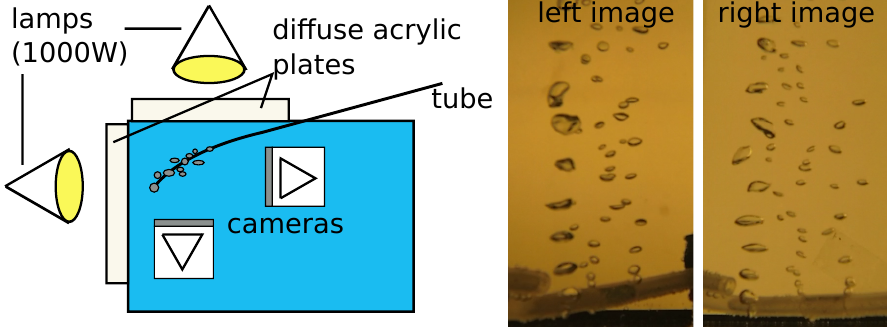
Figure 17. Left : test setup for evaluation of the system. Two back-illuminated planes provide a bright background behind an air bubble stream generated by a small tube. The cameras are arranged in a wide baseline setting viewing the scene from 90 ◦ different perspectives. Middle and right : exemplary images showing the produced bubble streams with small, ellipsoidal bubbles and large bubbles with arbitrary shapes.